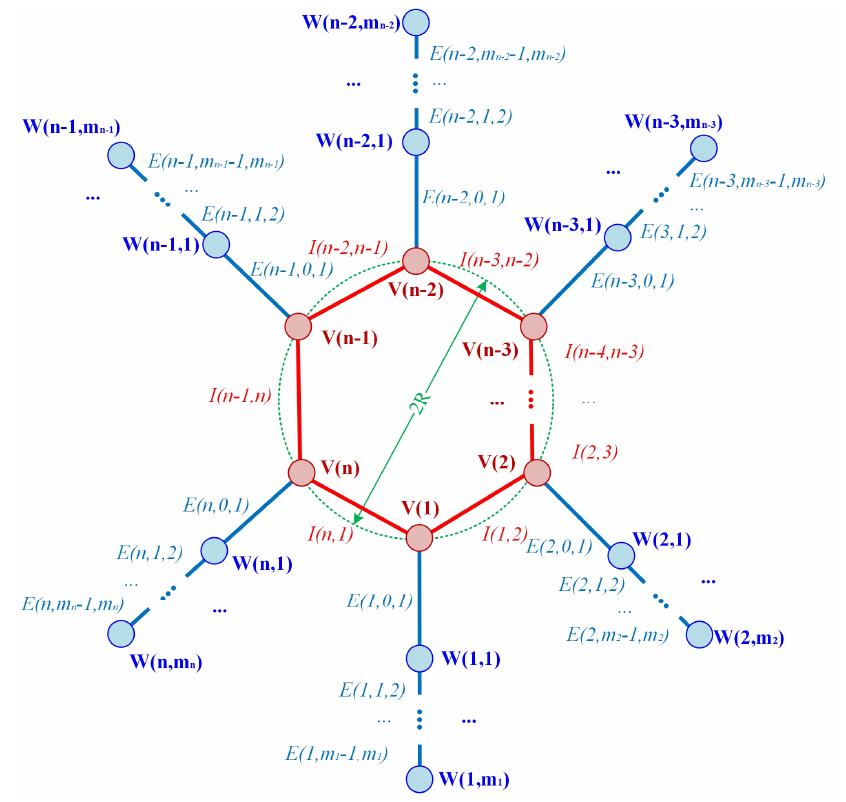
Figure 11. Theoretical geometrical model of the city logistics system of the concentrated sets of delivery locations.